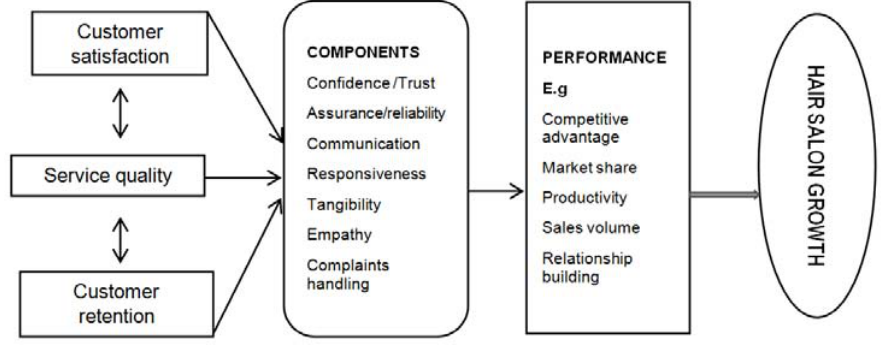
Fig. 1. Relationship marketing model (authors’